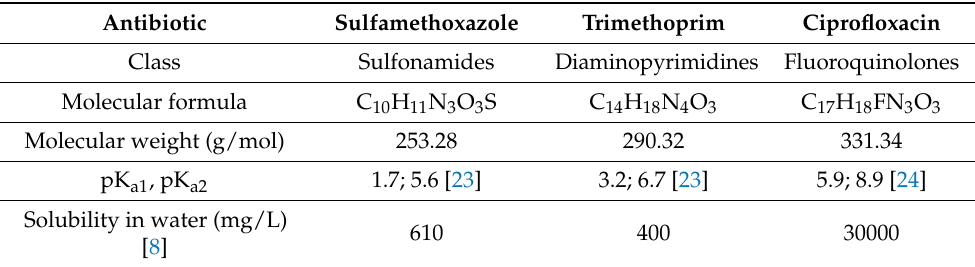
Scheme 1. Molecular structure of SMX, TMP and CIP and their 3D models. Table 2. Physicochemical properties of SMX, TMP and